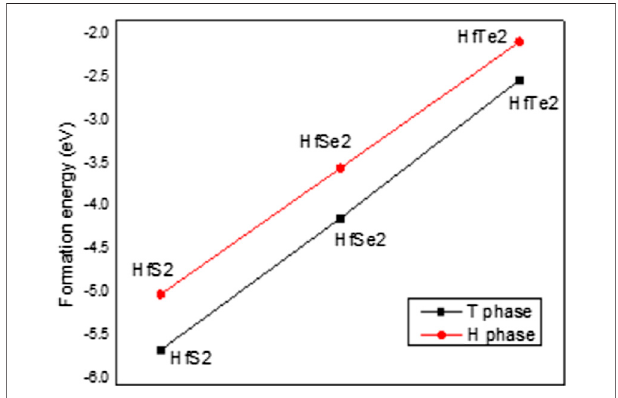
FIGURE 3 | Formation energy of HfX 2 in the T (black line) and H (red line) phases.